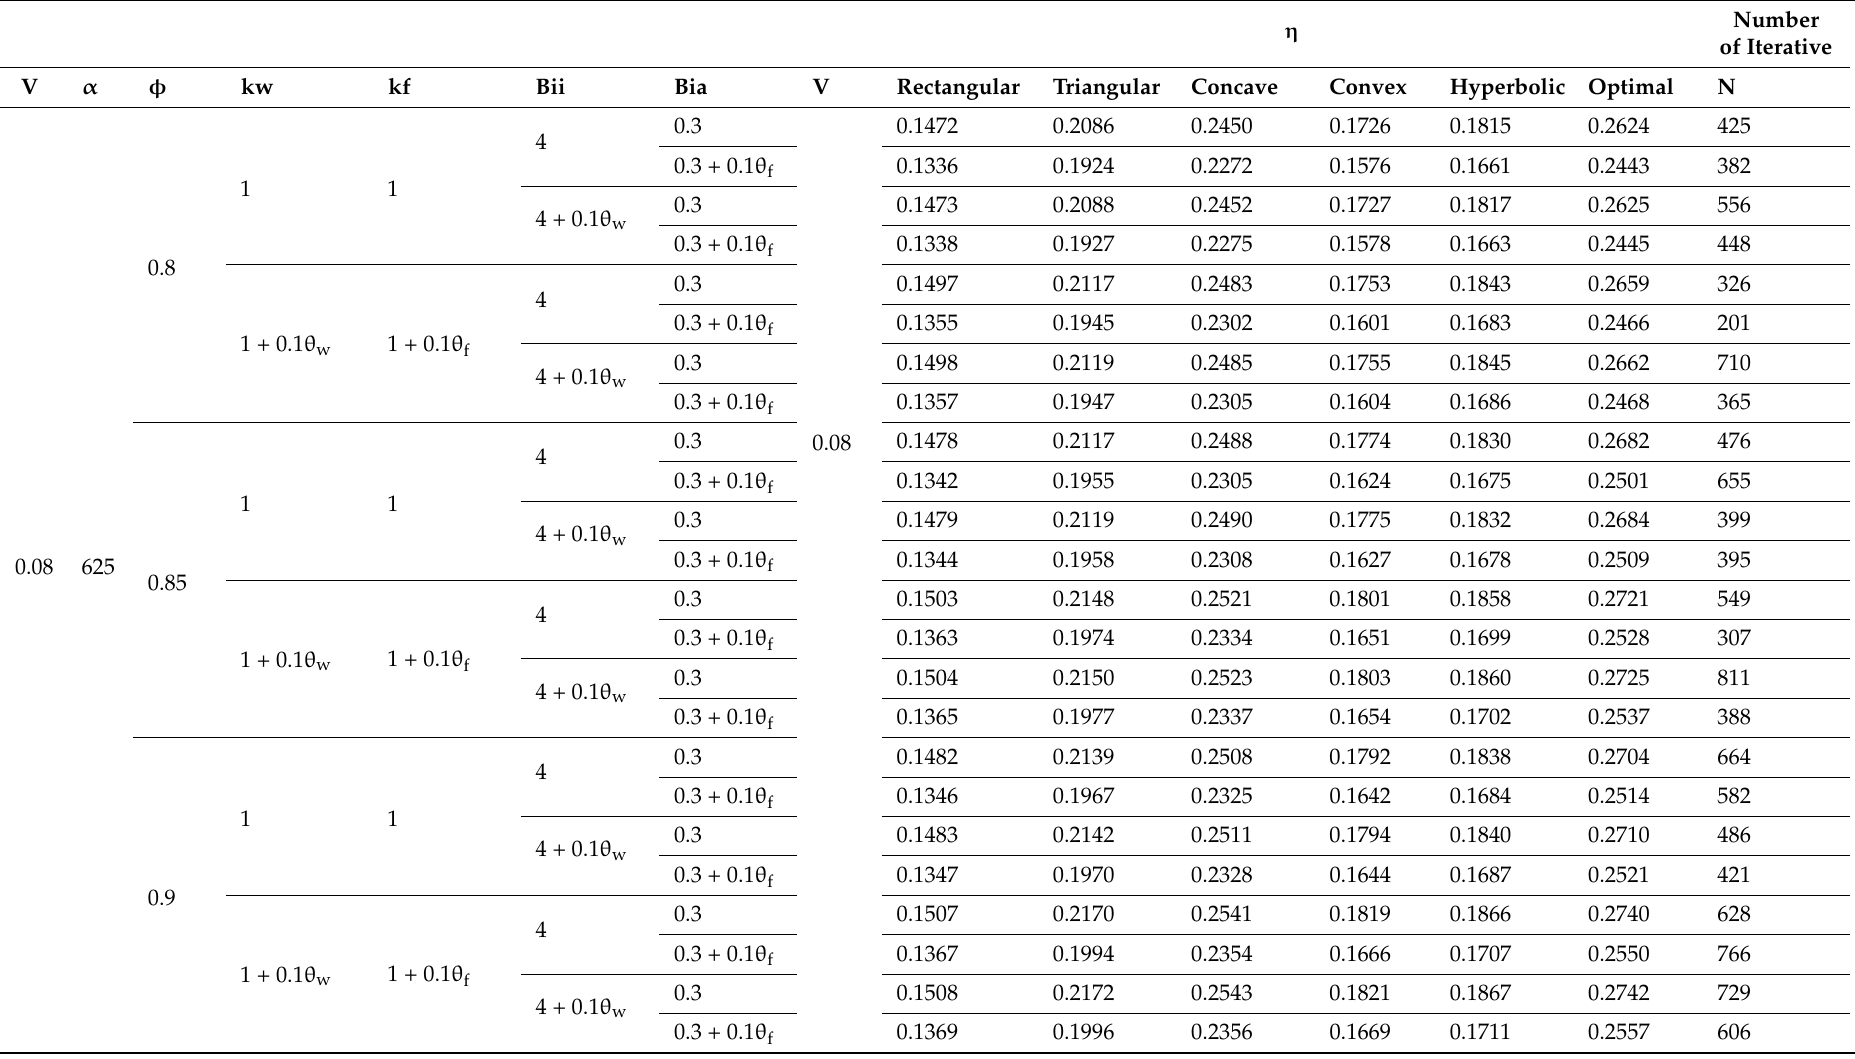
Table 1. The numerical solutions of η for different types of fins with various φ , k w , k f , Bi i , and Bi a